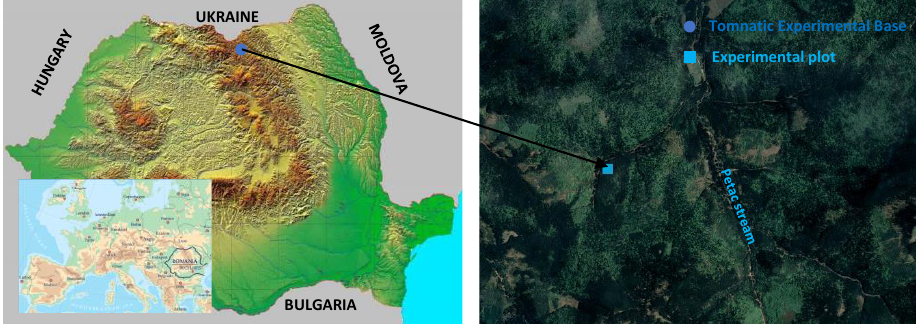
Figure 1. Location of experimental plot with different plantation variants for Norway spruce.